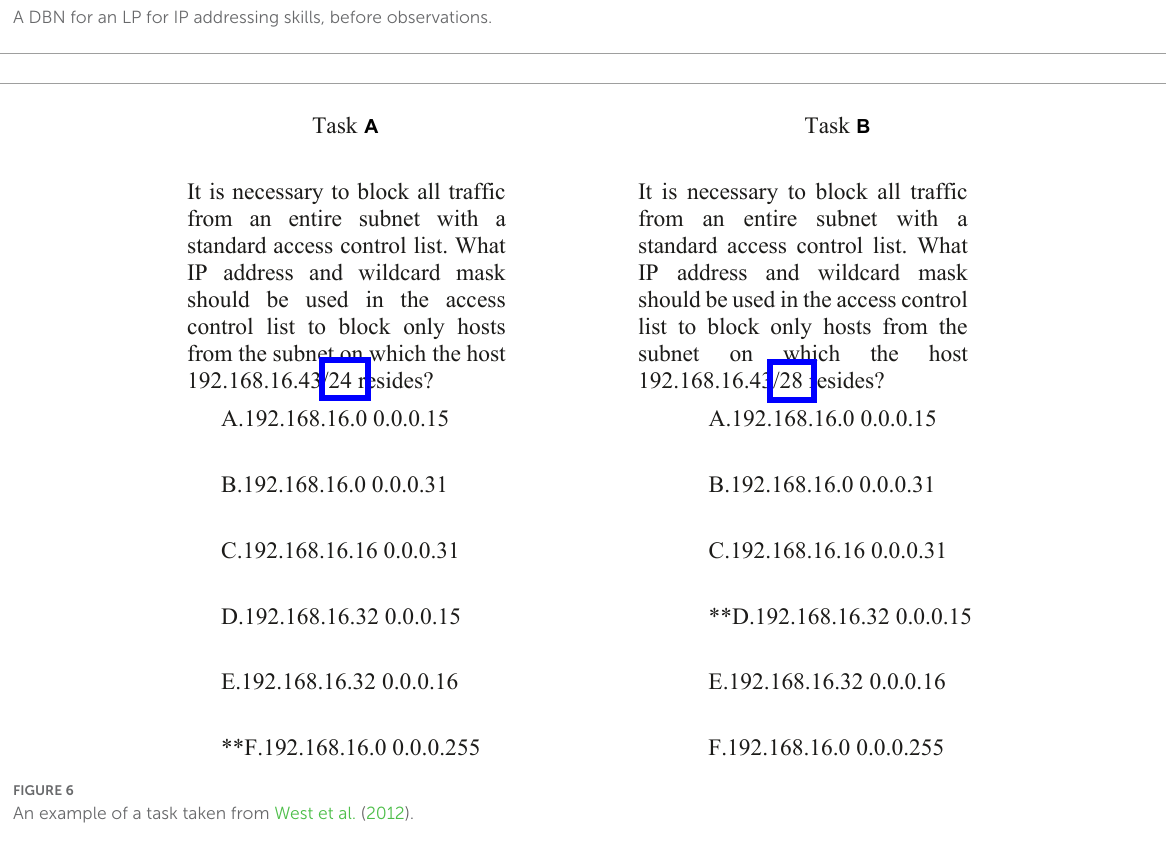
LP1_Task15 to LP1_Task17 and LP2_Task6 to LP2_Task9